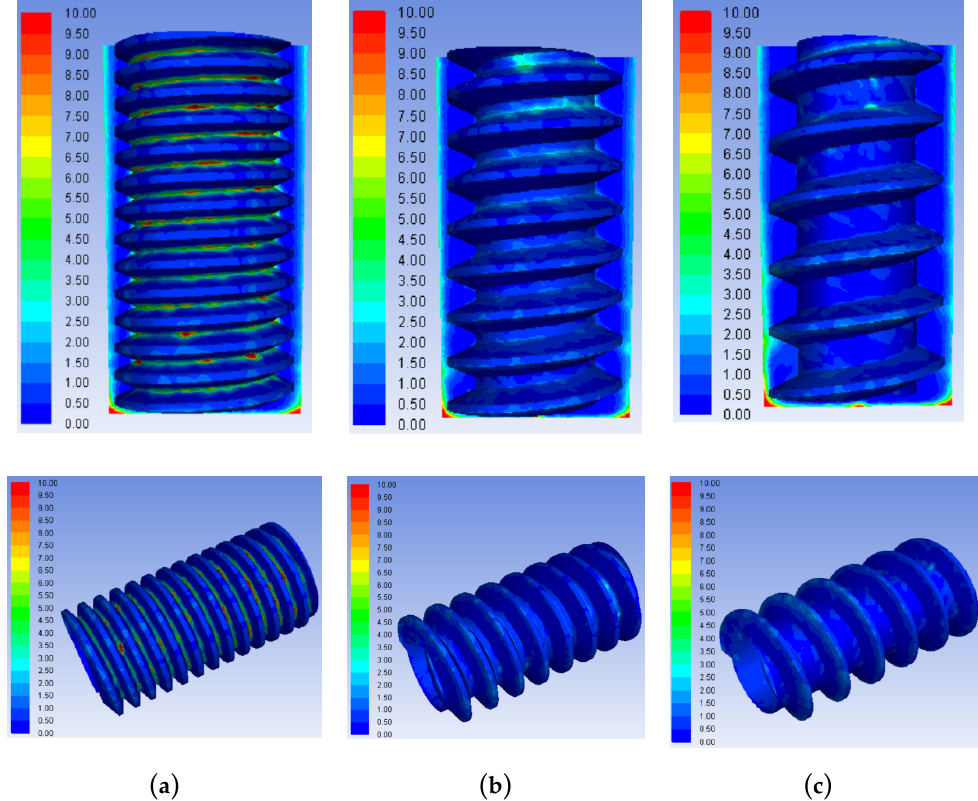
Figure 8. Concentration contours of processed products in the machining gaps using trapezoid helical electrodes with different pitches: ( a ) 0.15 mm; ( b ) 0.25 mm; and ( c ) 0.35 mm.